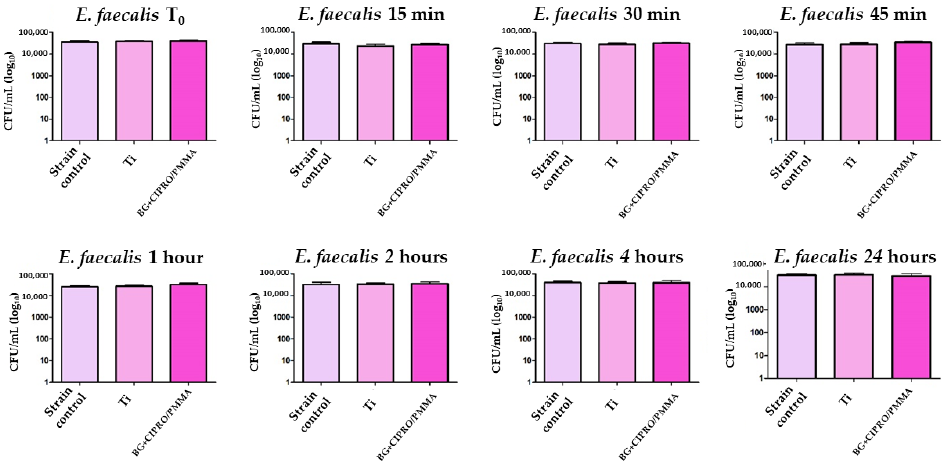
Figure 14. Evaluation of E. faecalis viability in the presence of bare Ti and BG+CIPRO/PMMA samples.